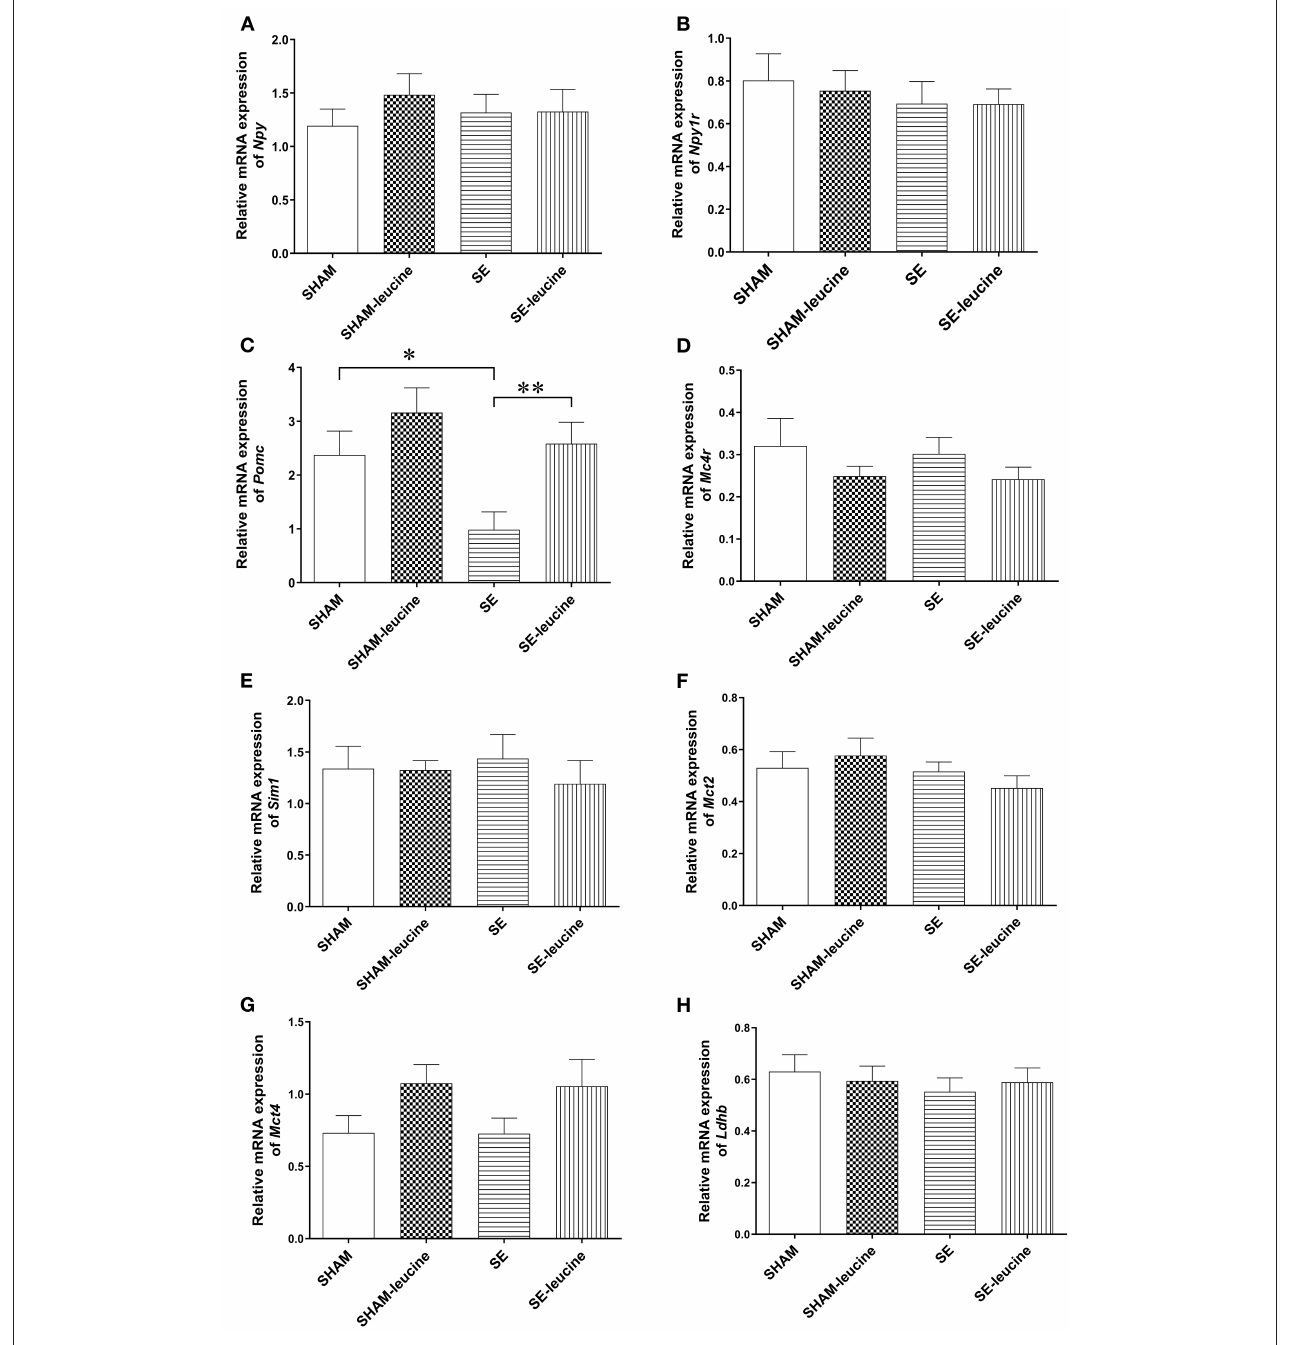
FIGURE 2 | Expression of metabolic regulators in the hypothalamus. The mRNA expression of Npy (A) , Npy1r (B) , Pomc (C) , Mc4R (D) , Sim1 (E) , Mct2 (F) , Mct4 (G) , and Ldhb (H) in the hypothalamus of female offspring at 13 weeks ( n = 8). Results are expressed as mean ± SEM and analyzed by two-way ANOVA, followed by post hoc LSD tests. * P < 0.05, ** P <